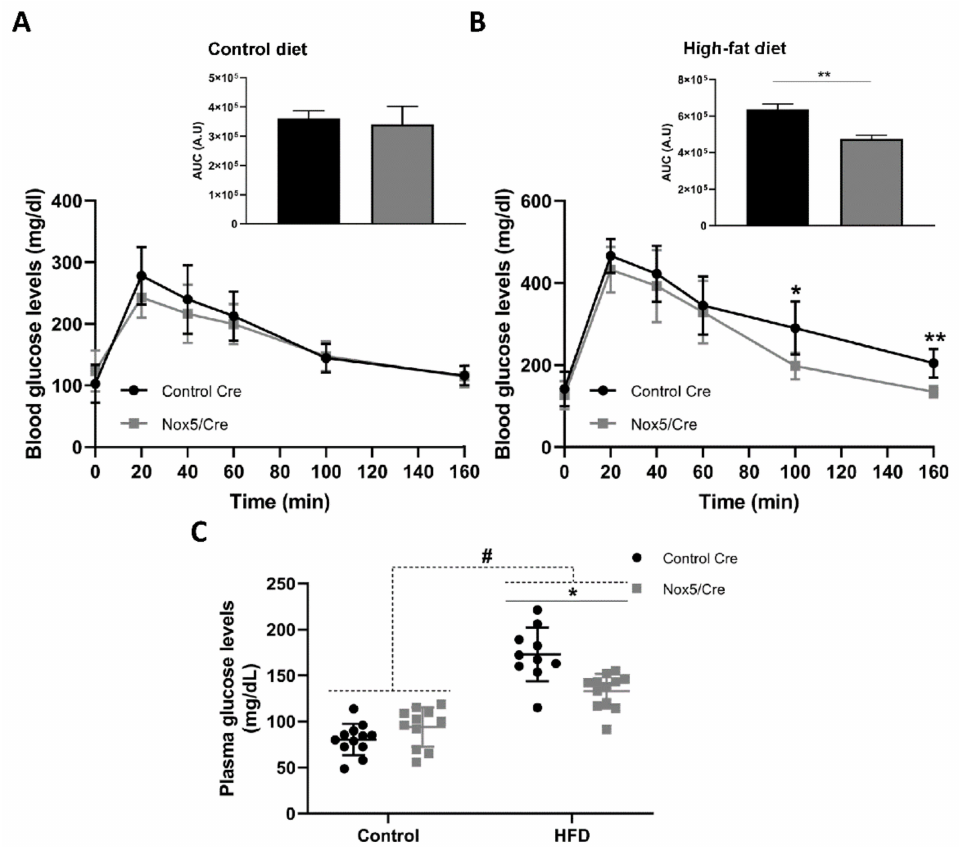
Figure 2. Endothelial NOX5 expression improved glucose uptake and reduced glycaemia in mice fed a HFD. ( A ) Intraperitoneal glucose tolerance test (IPGTT) performed in animals fed a control diet for 9 weeks. ( B ) IPGTT performed in animals fed a HFD for 9 weeks. ( C ) Plasma glucose levels after 10 weeks. Control diet: control Cre ( n = 12), Nox5/Cre ( n = 11); high-fat diet: control Cre ( n = 10), Nox5/Cre ( n = 12). Values are expressed as mean ± standard error of the mean (SEM). # p < 0.05: diet differences (dotted lines); * p < 0.05, ** p < 0.01: genotype differences (solid lines). Statistical tests used: t -test for ( A , B ), and area under the curve (AUC); two-way ANOVA for ( C ). A.U: arbitrary